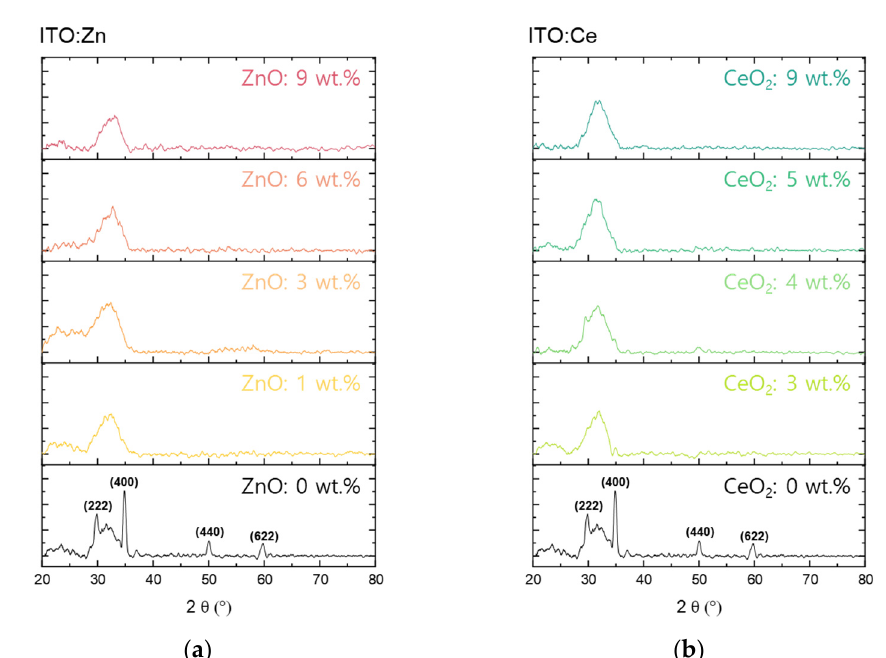
Figure 1. XRD patterns of ( a ) ZnO-doped ITO and ( b ) CeO 2 -doped ITO. The pure ITO exhibits a polycrystalline structure. The crystal structure of ITO doped with ZnO and CeO 2 becomes amorphous even with a small level of doping. There is no change in the diffraction pattern when the doping amount is further increased.